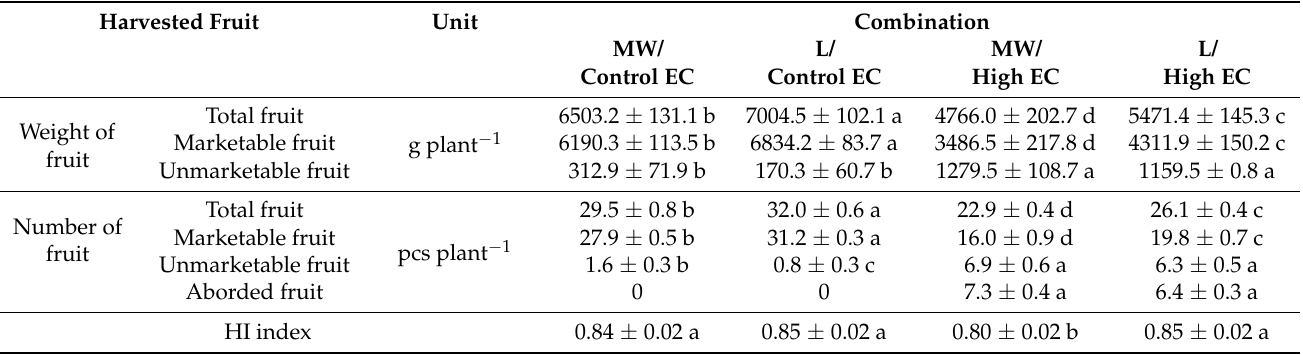
Table 3. Cucumber fruit yield by marketable and unmarketable fruit, number of fruit abortion and harvest index (average from two years).